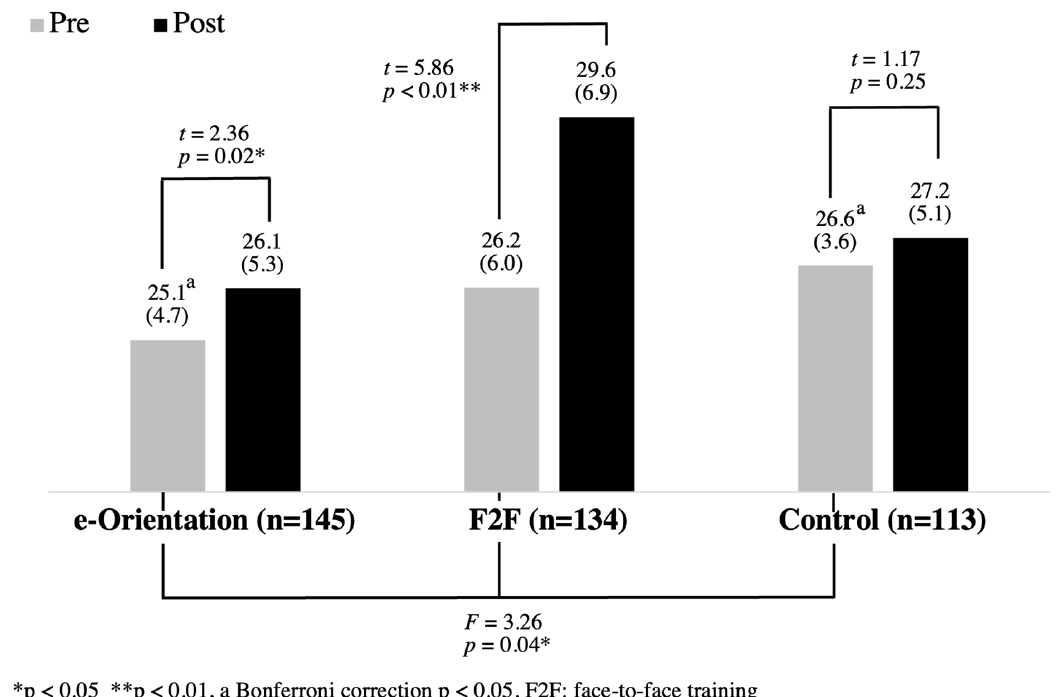
Figure 2. The PFA Confidence scores of the pre- and post-interventions (n = 392).